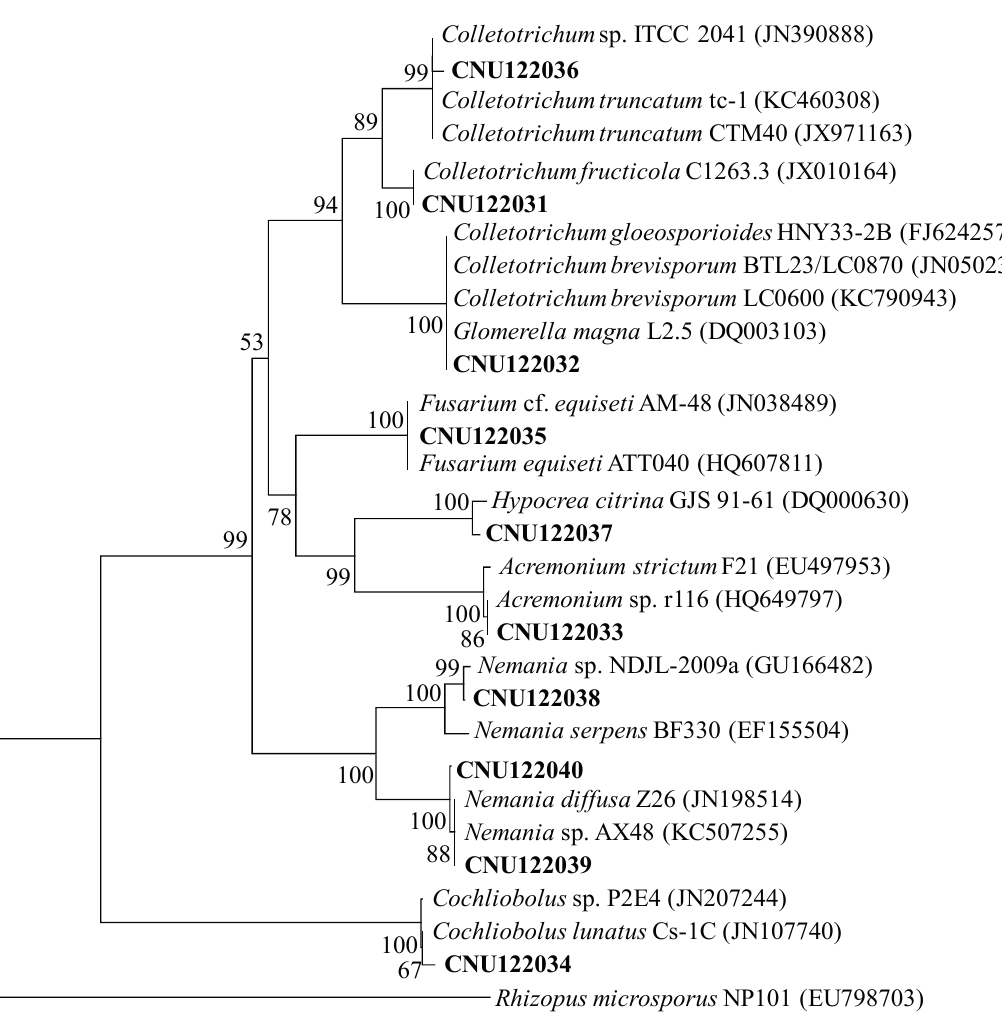
Figure 1. Neighbor-joining phylogenetic tree showing the placement of the representative endophytic isolates based on the sequences of the ITS region. The Kimura two-parameter model is used for pairwise distance measurement. The tree is rooted with Rhizopus microsporus (EU798703) . Only bootstrap values > 50% (1000 replications) are shown in at the internal